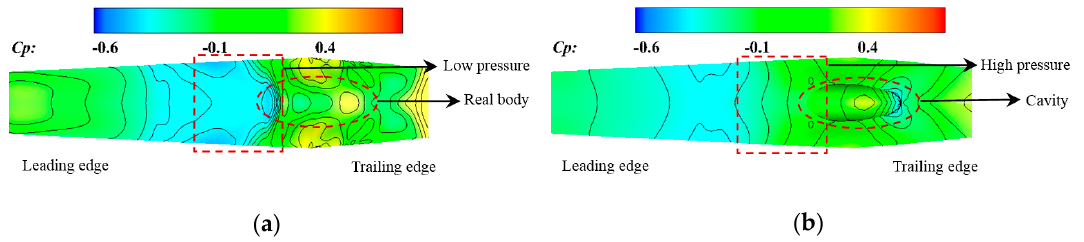
Figure 6. Pressure contour of the BWB aircraft lower surface with and without the V-shaped support ( Ma = 0.75, α = 0°): ( a ) pressure contour of the real model without support or cavity; ( b ) pressure contour of the test model with the V-shaped support (D52_L300_L2_P15) and cavity.